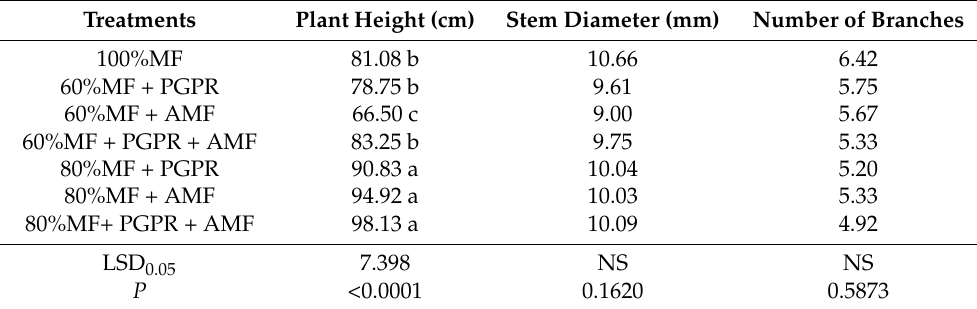
Table 2. Effects of the bio-fertilizers on plant height, diameter and branches, 80 DAT.